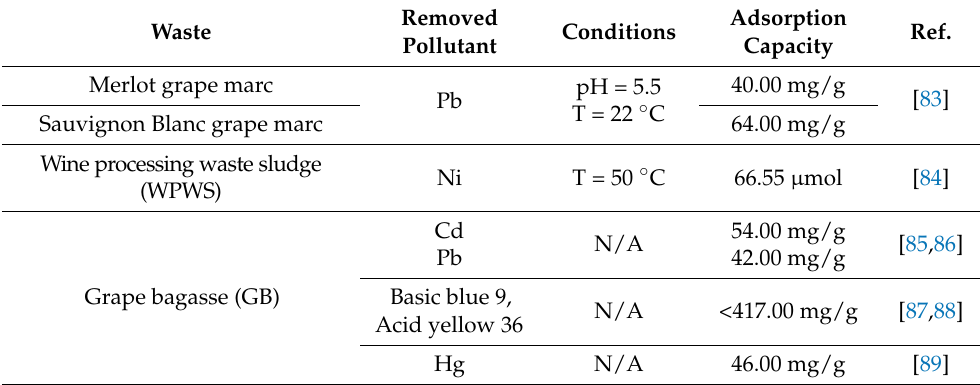
Table 5. Relevant examples of water treatment using winery wastes. Waste